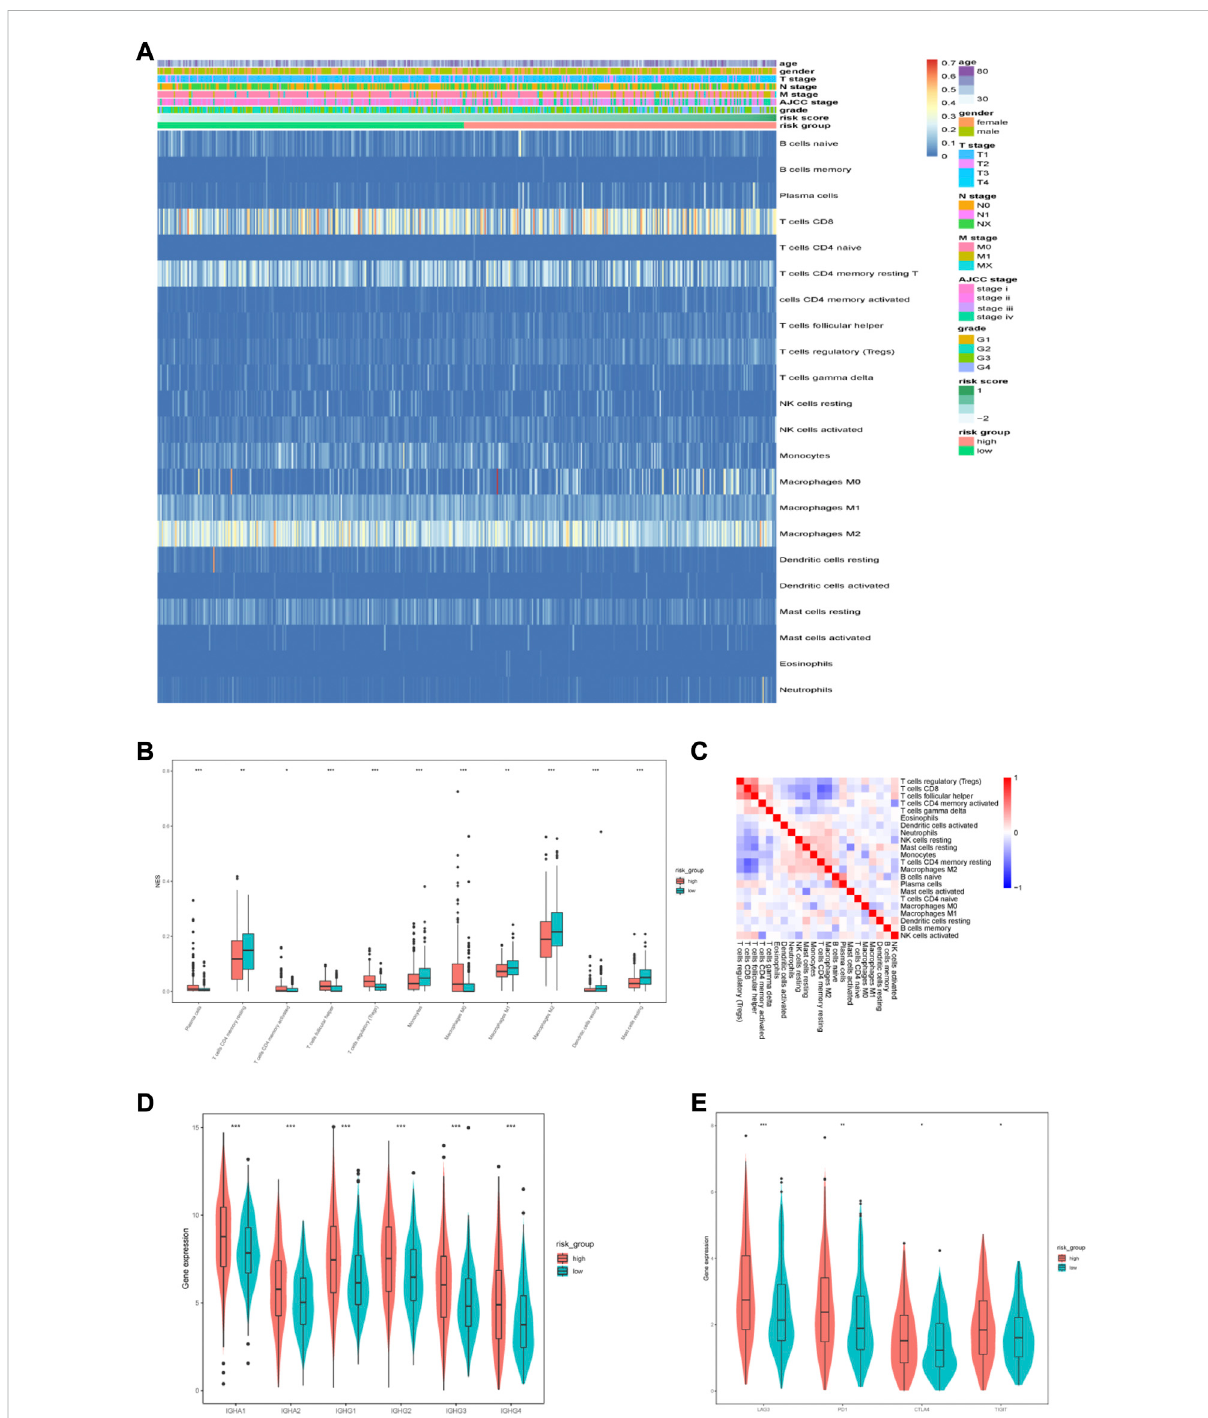
FIGURE 10 Immune characteristics of different risk groups. (A) Heatmap of the distribution of in fi ltrated immune cells and clinicopathological characteristics between the low-and high-risk groups. (B) Differentially in fi ltrated immune cells between the two risk groups. (C) Correlation analysis between in fi ltrated immune cells. (D) The expression of immunoglobulin in different risk groups. (E) The expression of ICPs in different risk